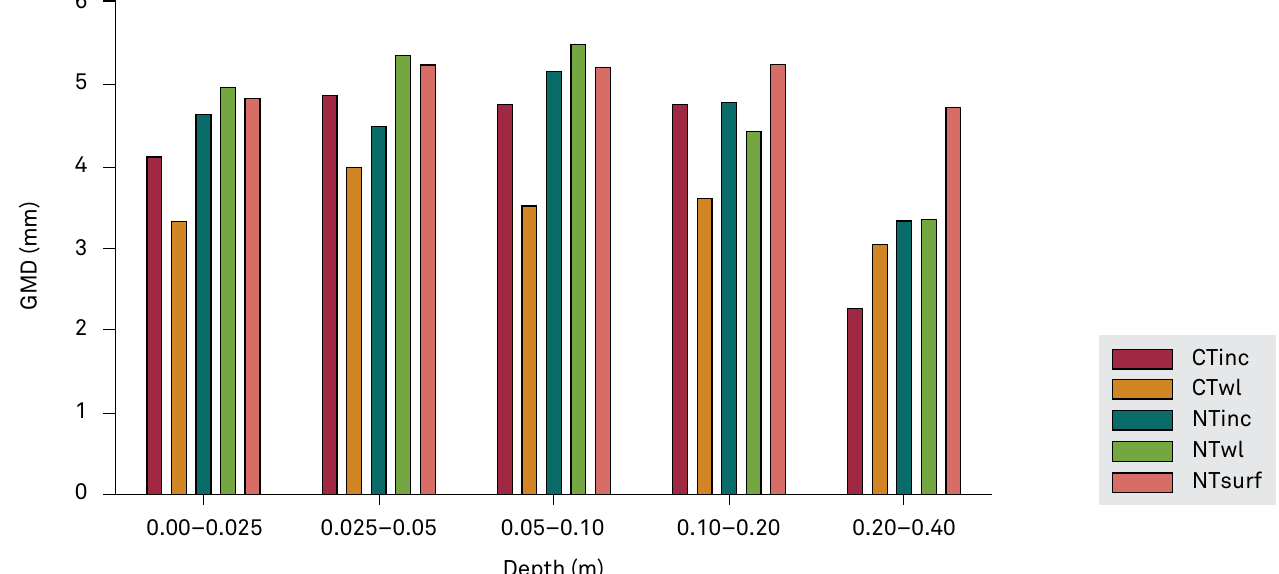
Figure 4. Geometric mean diameter (GMD) of soil aggregates as affected by tillage systems and liming methods at different depths of a Latossolo Bruno Alumínico típico (Hapludox). CTinc: conventional tillage with incorporated lime; CTwl: conventional tillage without lime; NTinc: no-tillage with incorporated lime; NTwl: no-tillage without lime; and NTsurf: no-tillage with surface